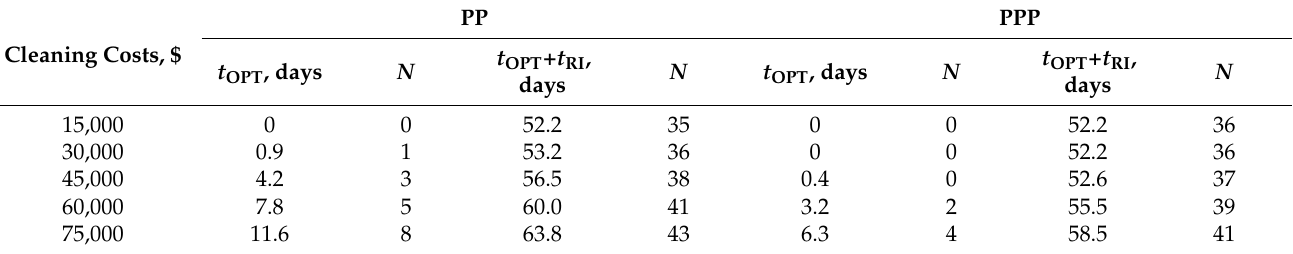
Table 7. Optimal timing for underwater cleaning.